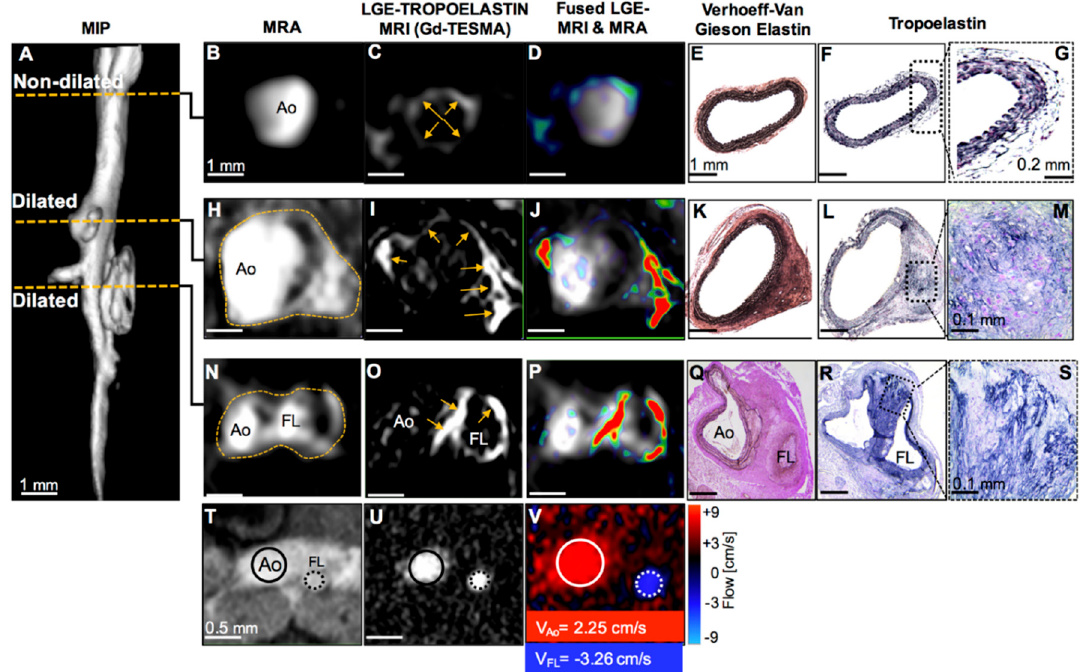
Figure 25. MRI of tropoelastin shows enhancement at sites of aortic aneurysm or dissection. ( A ) A reformatted MRA of an Ang II-infused ApoE − / − mouse shows two regions of aortic dilation. ( B – G ) MRA, LGE-MRI, and histology of a non-dilated segment show a normal aortic size, low enhancement after administration of Gd-TESMA, and lack of tropoelastin, respectively. ( H – M ) At the level of the first aortic dilation, there is vascular enhancement of the aneurysm after administration of Gd-TESMA that co-localized with the accumulation of tropoelastin as verified histologically. ( N – P and T – V ) At the level of the second aortic dilation, MRI images show the formation of a false lumen indicative of an aortic dissection, with aortic enhancement after administration of Gd-TESMA and retrograde blood flow. ( Q – S ) Histology verified the formation of two lumens and the accumulation of tropoelastin in areas where vascular enhancement was observed in vivo using the tropoelastin agent. Ao, aorta; FL, false lumen. Reproduced with permission from Lavin et al., 2019 [158].